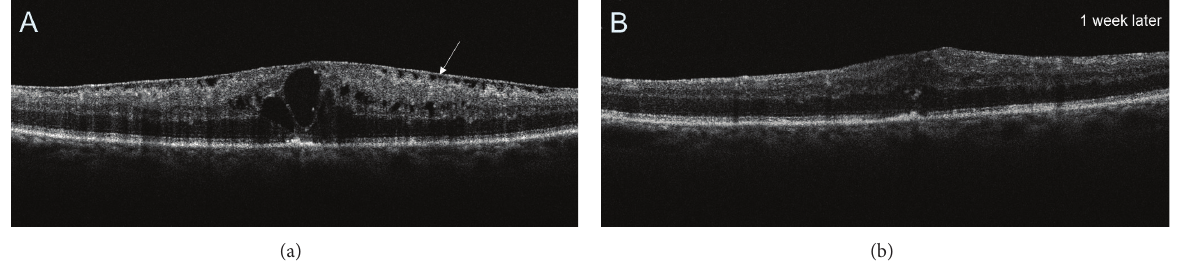
Figure 9: (a) Preoperative SDOCT tomogram demonstrating epiretinal membrane (arrow) and cystoid DME. (b) Postoperative SDOCT image obtained 1 week after vitrectomy showing decreased retinal thickness and no intraretinal cystic spaces. Normal foveal depression is still